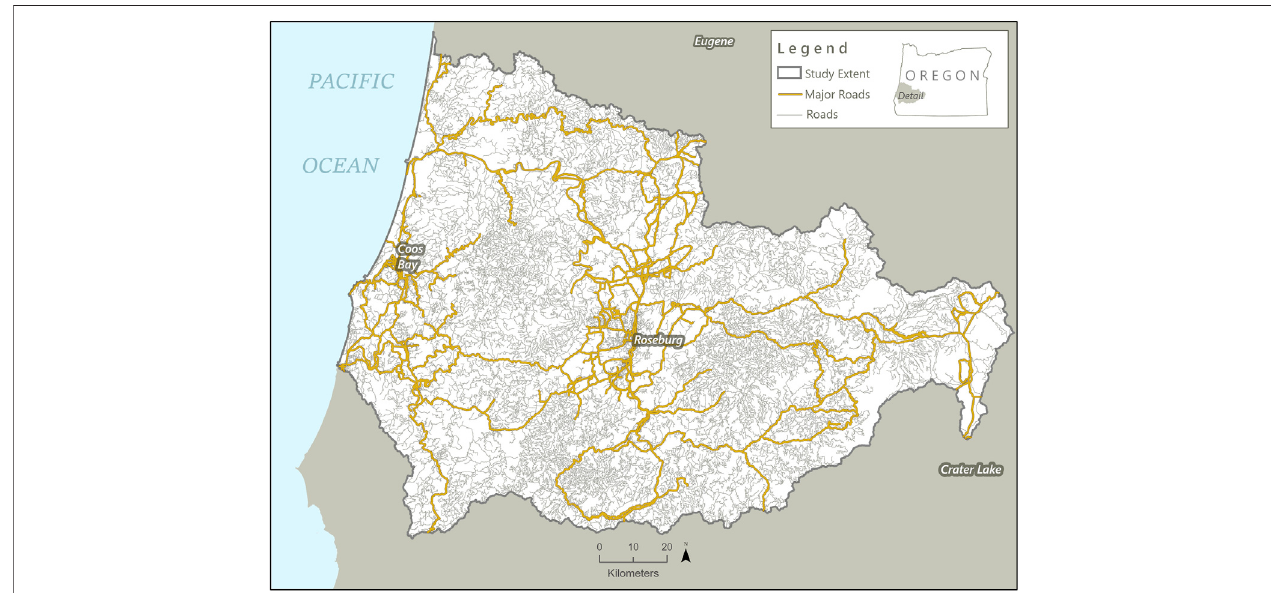
FIGURE 1 | Map of study area highlighting all of the roads present in the region. Roads highlighted in orange are the primary roads (Interstate 5, large arterial roadways, and connecting regional roads) that were used in analysis; other roads are indicated in brown.